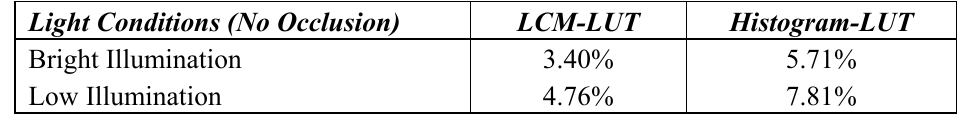
Table 4. Average noisy pixels in the segmented image for different